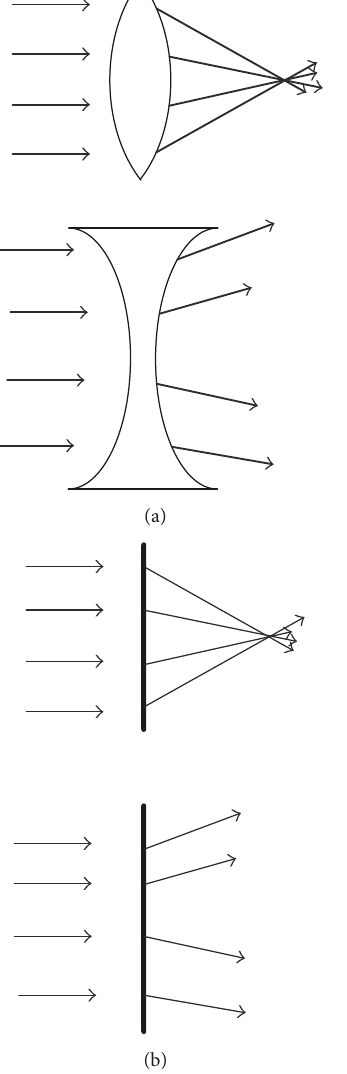
Figure 7: (a) Conventional optical lenses should be curved for focusing or defocusing the light; (b) planar Huygens’ metasheets behave like a lens by locally controlling electric and magnetic currents induced on the surface [49,